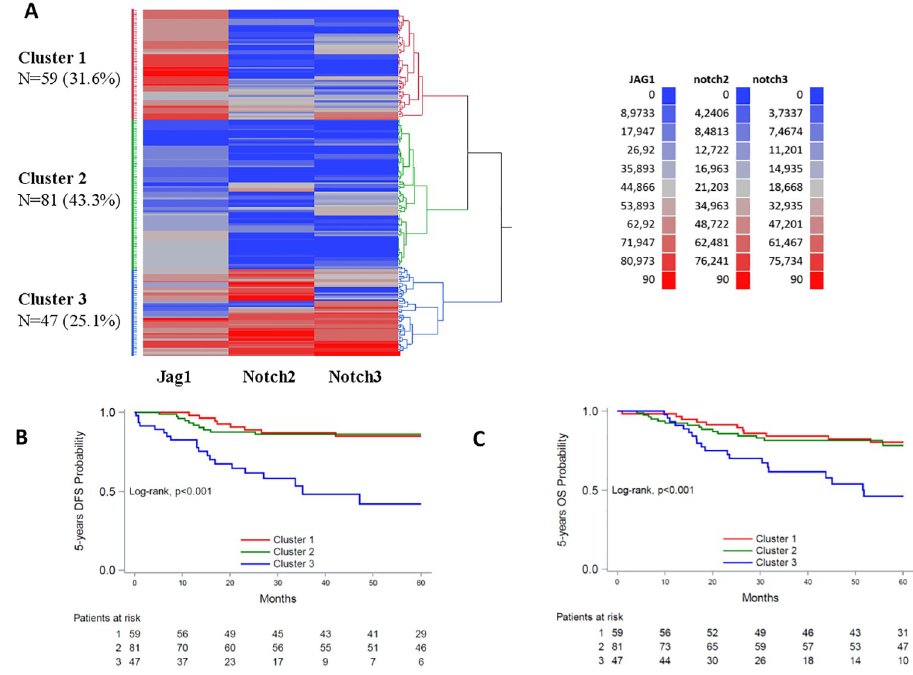
Fig 3. Evaluation of Jag1-Notch pathway activation patterns. A: Hierarchical clustering of continuous IHC measurements, N = 187. B, C: Kaplan-Meier curves according to cluster membership. B: 5-year DFS; C: 5-year OS.